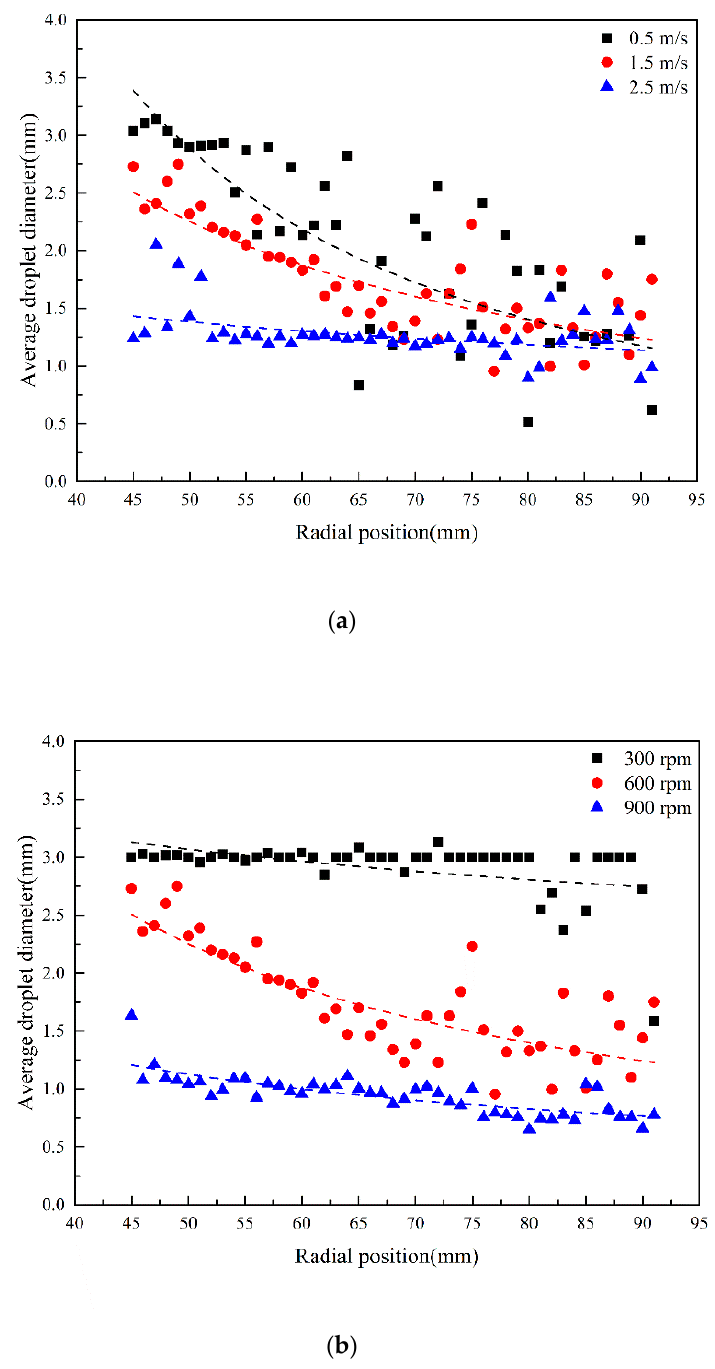
Figure 16. Effect of initial droplet velocity and rotating speed on average droplet diameter. ( a ) 𝑑 (cid:2868) = 3 = 3 mm, u = 1.5 m / mm, 𝜔 = 600 rpm; ( b ) 𝑑 (cid:2868) = 3 mm, 𝑢 (cid:2868) = 1.5 m/s. ω = 600 rpm; ( b ) d 0 0